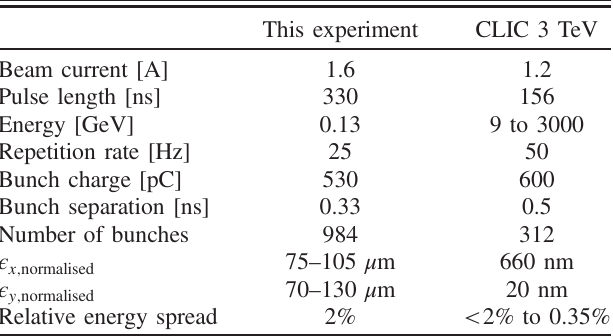
TABLE I. Beam parameters used for the experiment and CLIC 3 TeV design parameters [1,14].